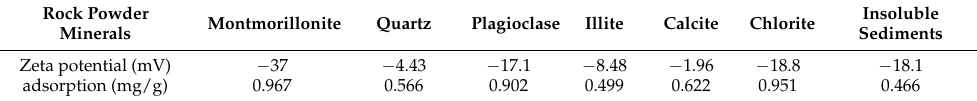
Figure 10. Adsorption curves of PAC30 in different minerals. Table 4. Adsorption capacity of different minerals on PAC30 and charge of mineral surface.